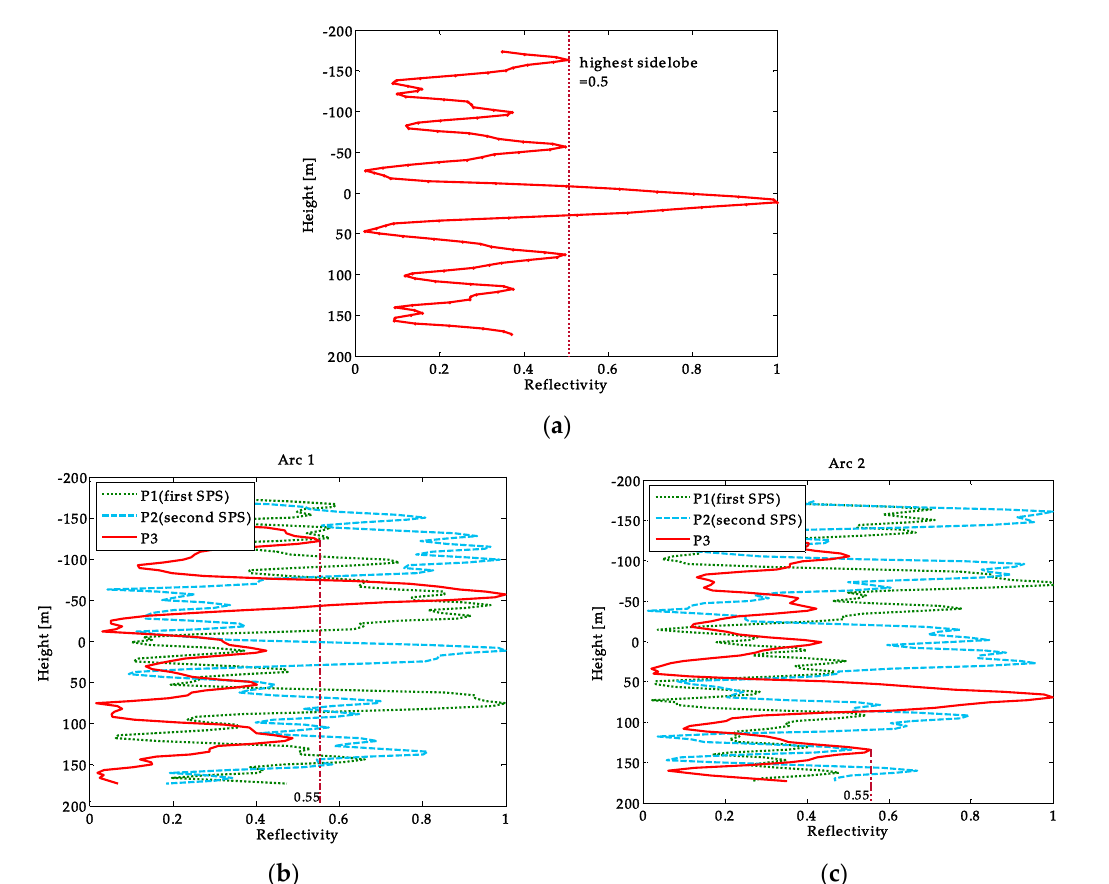
Figure 9. Reconstructed reflectivity profiles. ( a ) The ideal reflectivity profile with no phase error; ( b ) the reconstructed reflectivity of arc 1; ( c ) the reconstructed reflectivity of arc 2. P1: the reconstructed reflectivity profile of the first SPS point of one SPS arc without APS calibration. P2: the reconstructed reflectivity profile of the second SPS point of one SPS arc without APS calibration. P3: the reconstructed reflectivity profile of the relative measurements of an SPS arc after APS calibration.